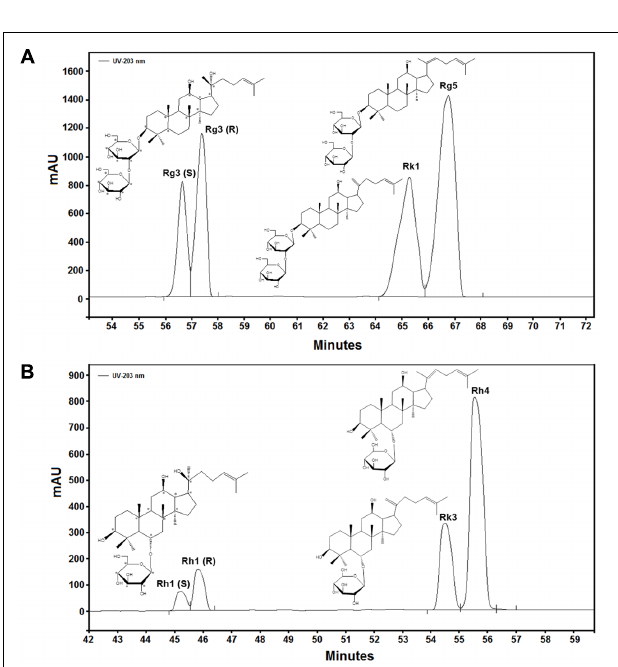
FIGURE 2 | HPLC chromatograms of PPD (A) and PPT (B) .